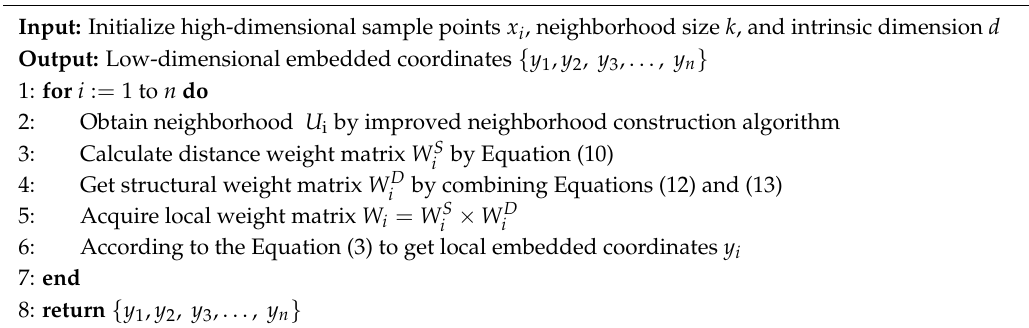
Algorithm 1 M-LLE